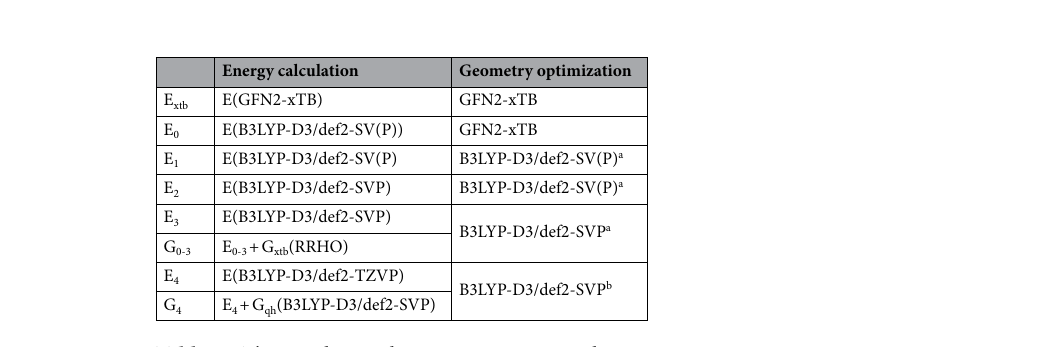
Table 1. Thermochemical recipes. a Loose NWChem geometry convergence criteria: gmax 0.002; grms 0.0003; xmax